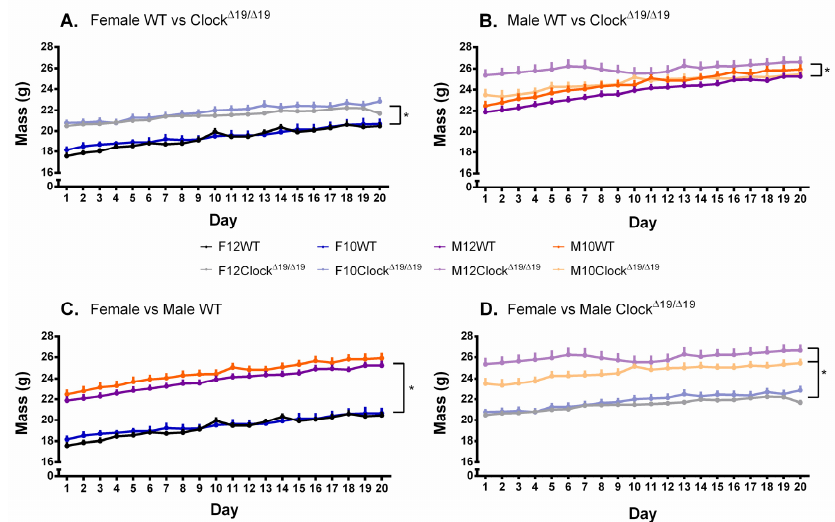
Figure 8. Changes in mouse body weight over time are influenced by sex, genotype, number of drinking days, and L:D cycle. ( A ). Female WT mice demonstrated greater body weights compared to female Clock Δ 19/ Δ 19 mice; an effect most prominent in female 12:12 WT mice. ( B ). Male WT mice demonstrated greater body weights compared to male Clock Δ 19/ Δ 19 mice; an effect most prominent in male 12:12 WT mice. ( C ). Female and male WT mice demonstrated similar body weights, with the greatest observable differences being in the female 12:12 mice and male 10:10 mice. ( D ). Female and male Clock Δ 19/ Δ 19 mice demonstrated similar body weights, with the greatest observable differences being in the male 12:12 and 10:10 mice. F = females, M = males; 12 = 12:12 L:D cycle, 10 = 10:10 L:D cycle; WT = wild-type. Darker tones are WT mice and lighter tones are Clock Δ 19/ Δ 19 mice. Black = female 12:12 L:D group, blue = female 10:10 L:D group, purple = male 12:12 L:D group, orange = male 10:10 L:D group. * = p < 0.05.